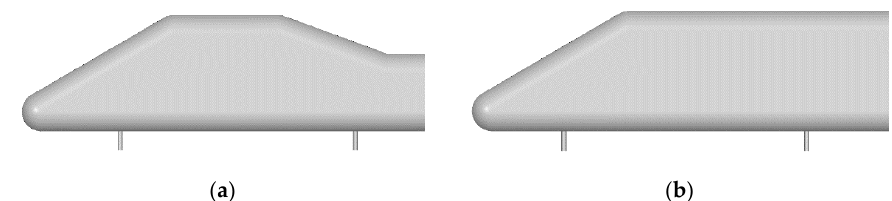
Figure 4. ( a ) Society of Automotive Engineers (SAE) reference body, notchback; ( b ) SAE reference body, squareback.